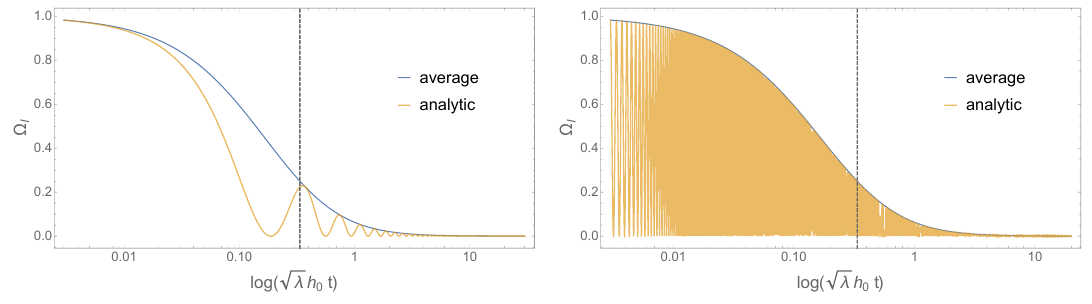
Figure 10 . The evolution of the in(cid:13)aton density with the mass parameter m (cid:30) = 0 : 01 (cid:2) (cid:3) 2 (left panel) and m (cid:30) = 10 (cid:2) (cid:3) 2 = (cid:3) (right panel). The blue-solid line shows the averaged expectation I value. The dashed line is the time when maximum temperature is reached.